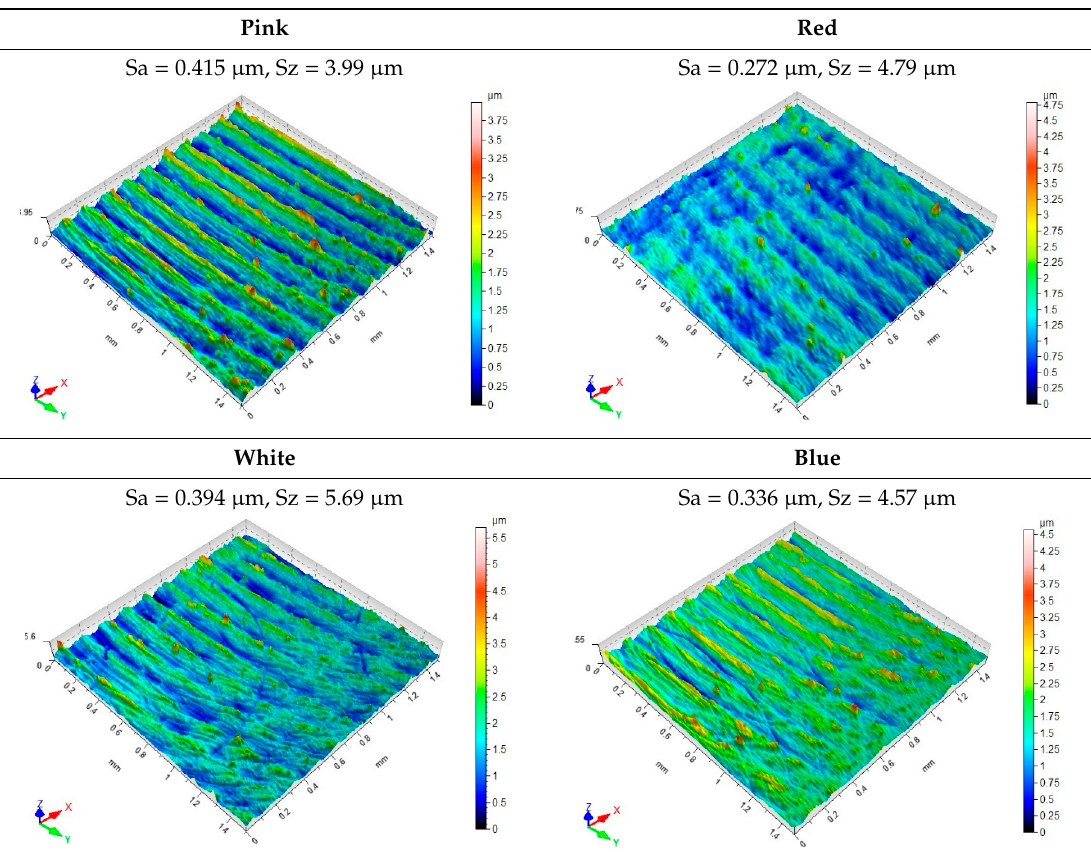
Figure 12. Roughness following milling: ( a ) topography; ( b ) parameters. Table 3. Surface topography after brushing with the “low” spring in the offset adjustment sleeve.